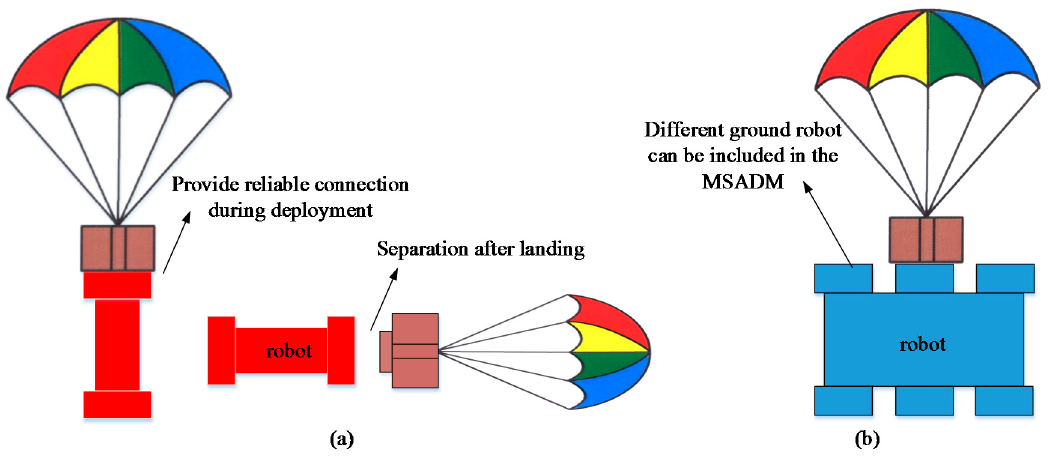
Figure 8. ( a ) Function of the separation device. ( b ) Any ground robot sharing the corresponding mechanical interface with separation device can quickly be included in the MSADM.